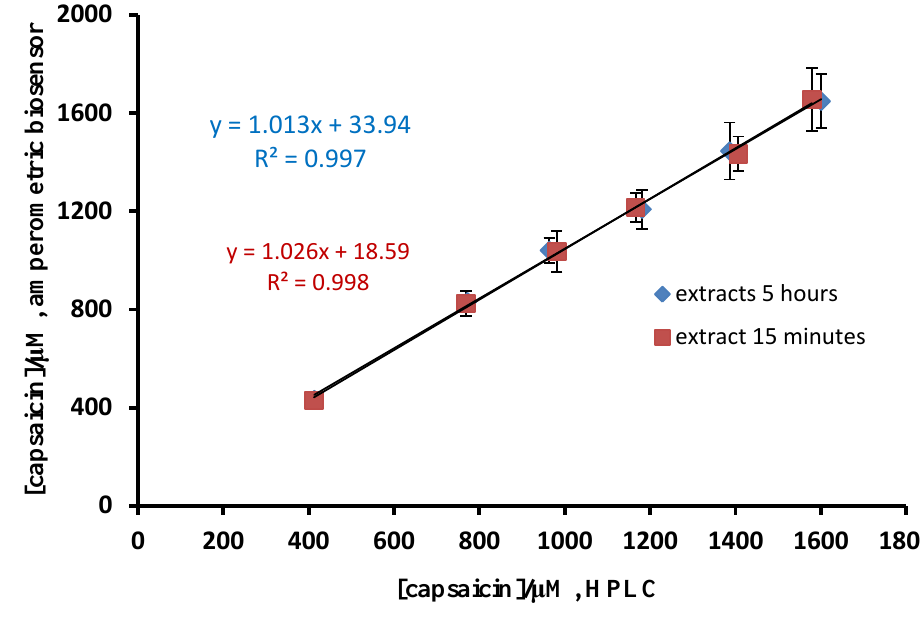
Figure 8. A comparison between the capsaicin biosensor and HPLC method for the determination of capsaicin.